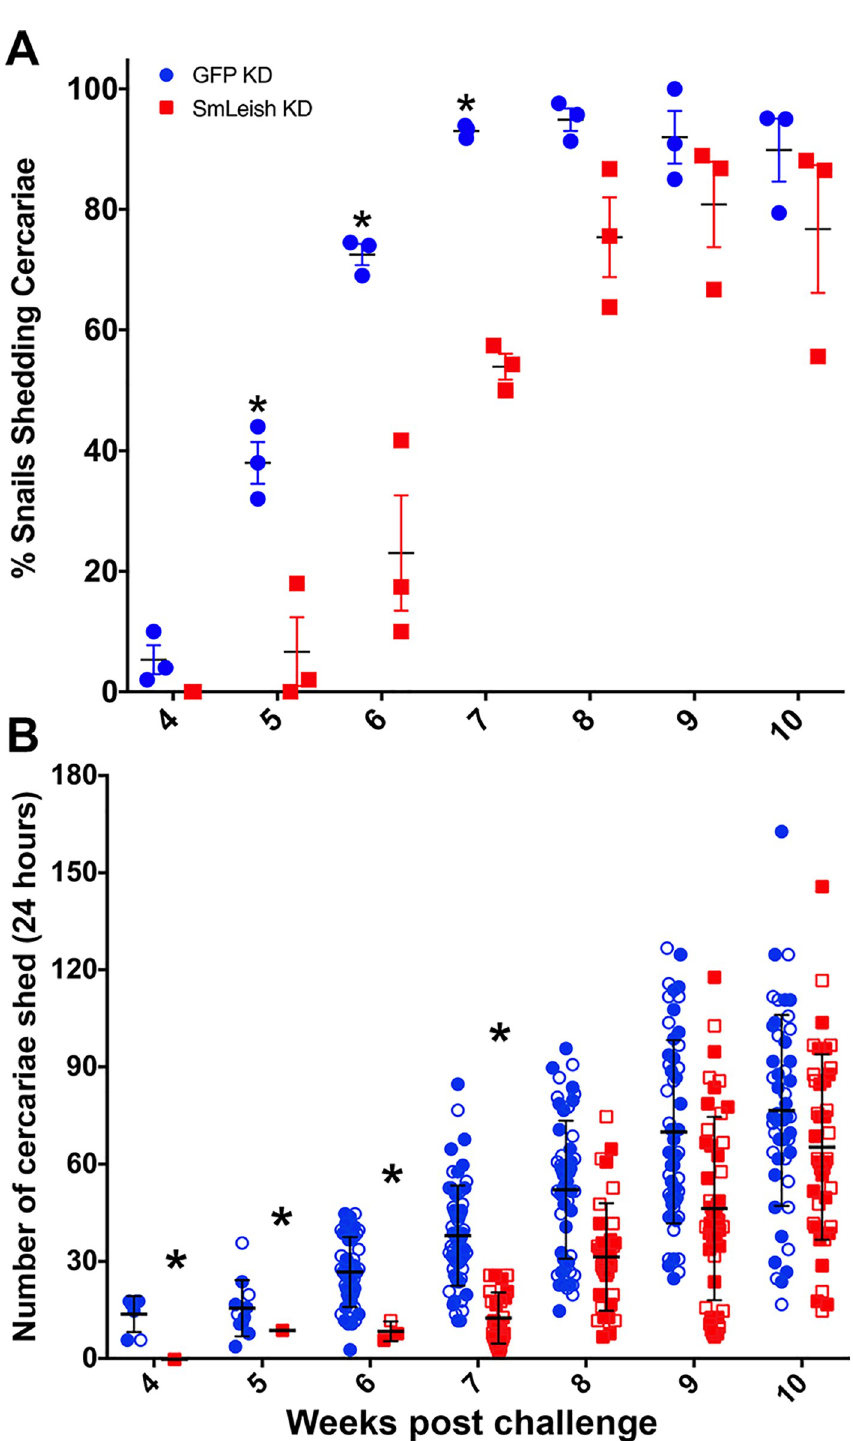
Fig 5. Knockdown of SmLeish influences S . mansoni infection kinetics and cercarial output. (A) Knockdown of SmLeish prior to challenge of M-line B . glabrata reduced the early infection success of the parasite as measured by the number of S . mansoni -challenged B . glabrata that shed cercaria at 4, 5, 6, 7, 8, 9 and 10 weeks post challenge compared to GFP knockdown control parasites. Long-term infection success was not statistically changed after 8-weeks post challenge, suggesting that knockdown of SmLeish may reduce the number of miracidia (out of the 5 each snail was exposed to) that successfully infected the snail. However, significant differences were observed ( � ) at 5, 6 and 7